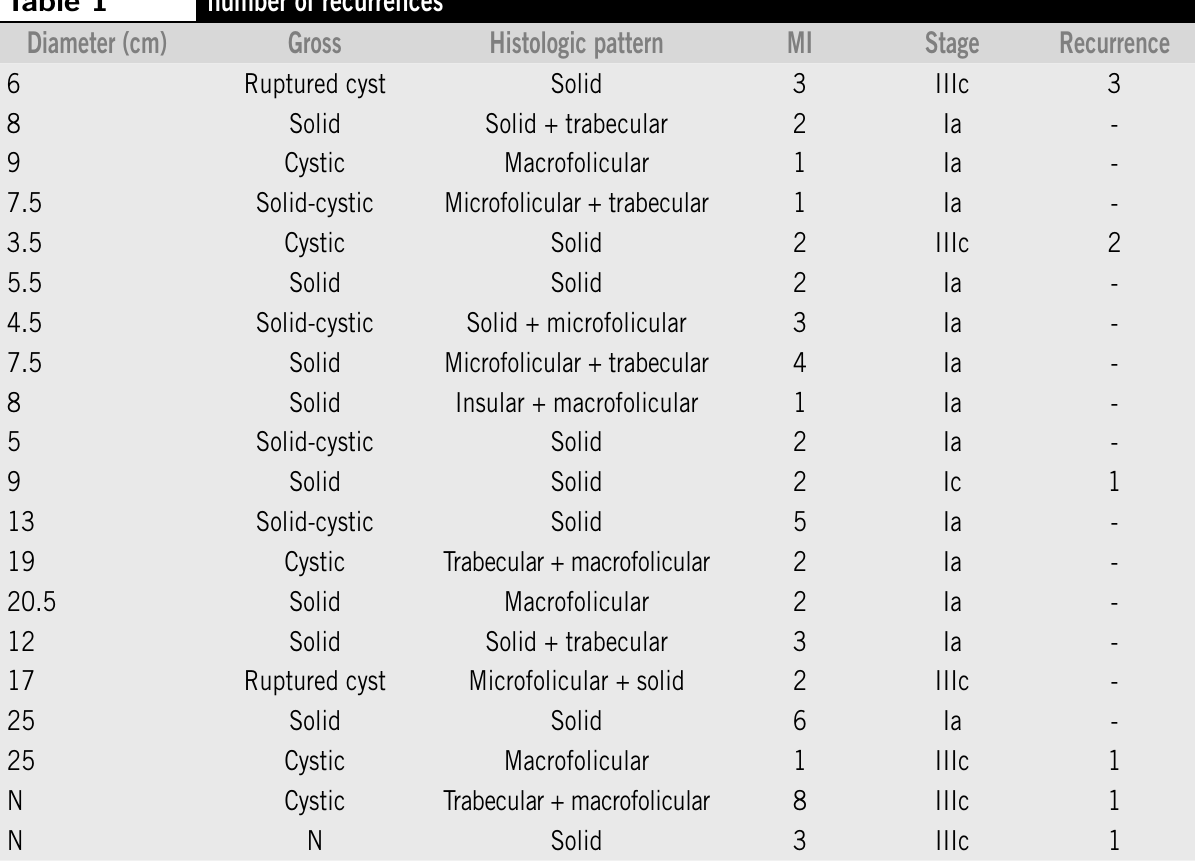
Case description according to gross aspects, hystological patterns, stage of the disease and number of